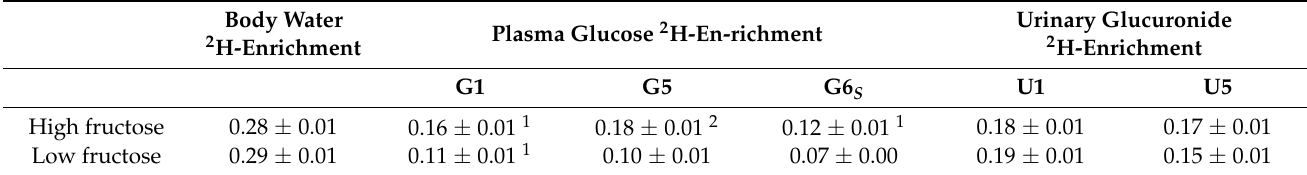
Table 2. 2 H-enrichment of body water, plasma glucose positions 1, 5 and 6S (G1, G5, G6 S ) and urinary glucuronide positions 1 and 5 (U1, U5) following ingestion of a meal containing 50 g of sugar with a 5/95 fructose/glucose proportion (Low fructose) and a meal containing 50 g of sugar with a 55/45 fructose/glucose proportion (High fructose).